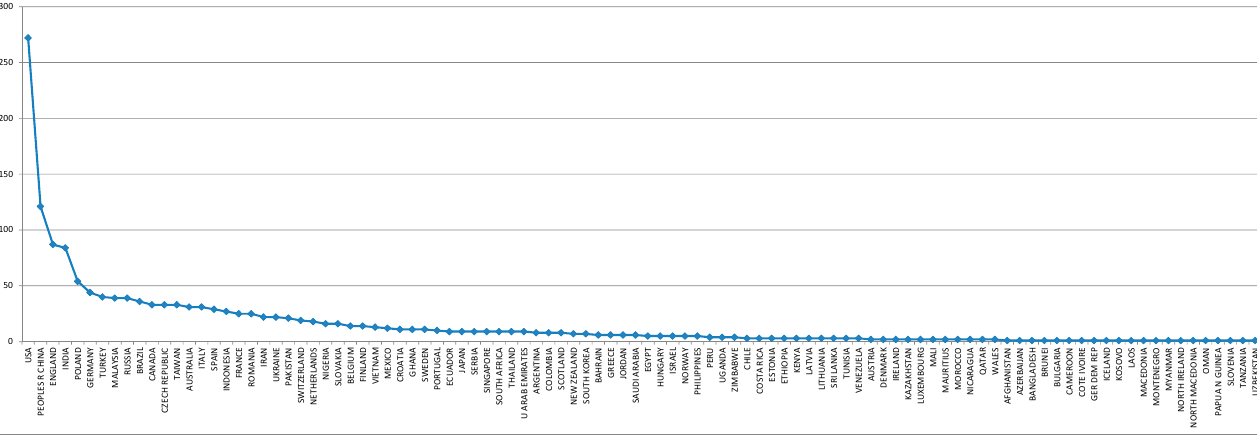
Figure 5. Distribution of records by country/region (WoS).